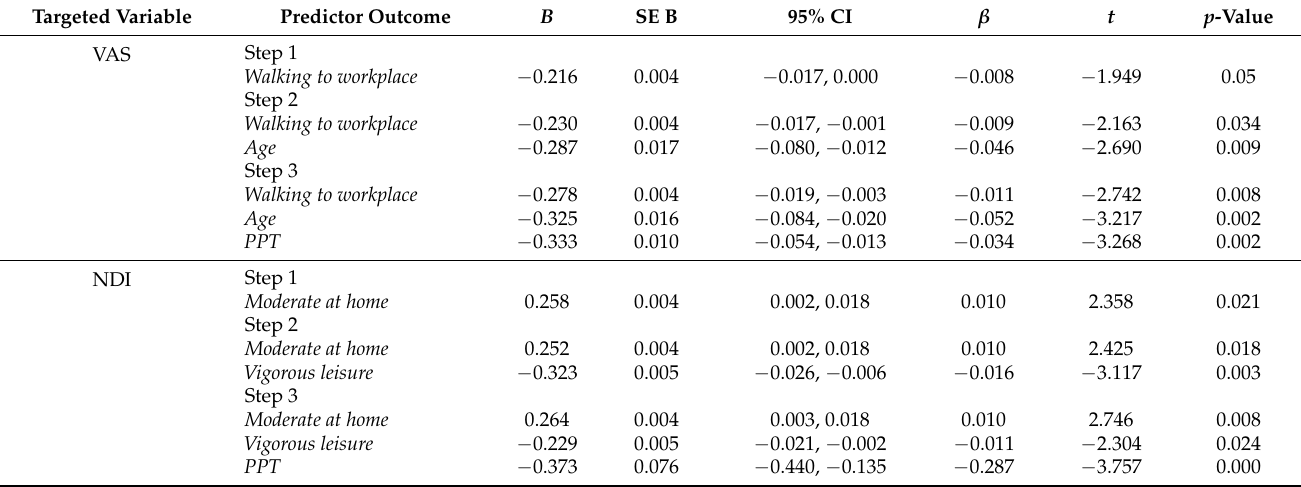
Table 5. Summary of the regression analyses to determine pain